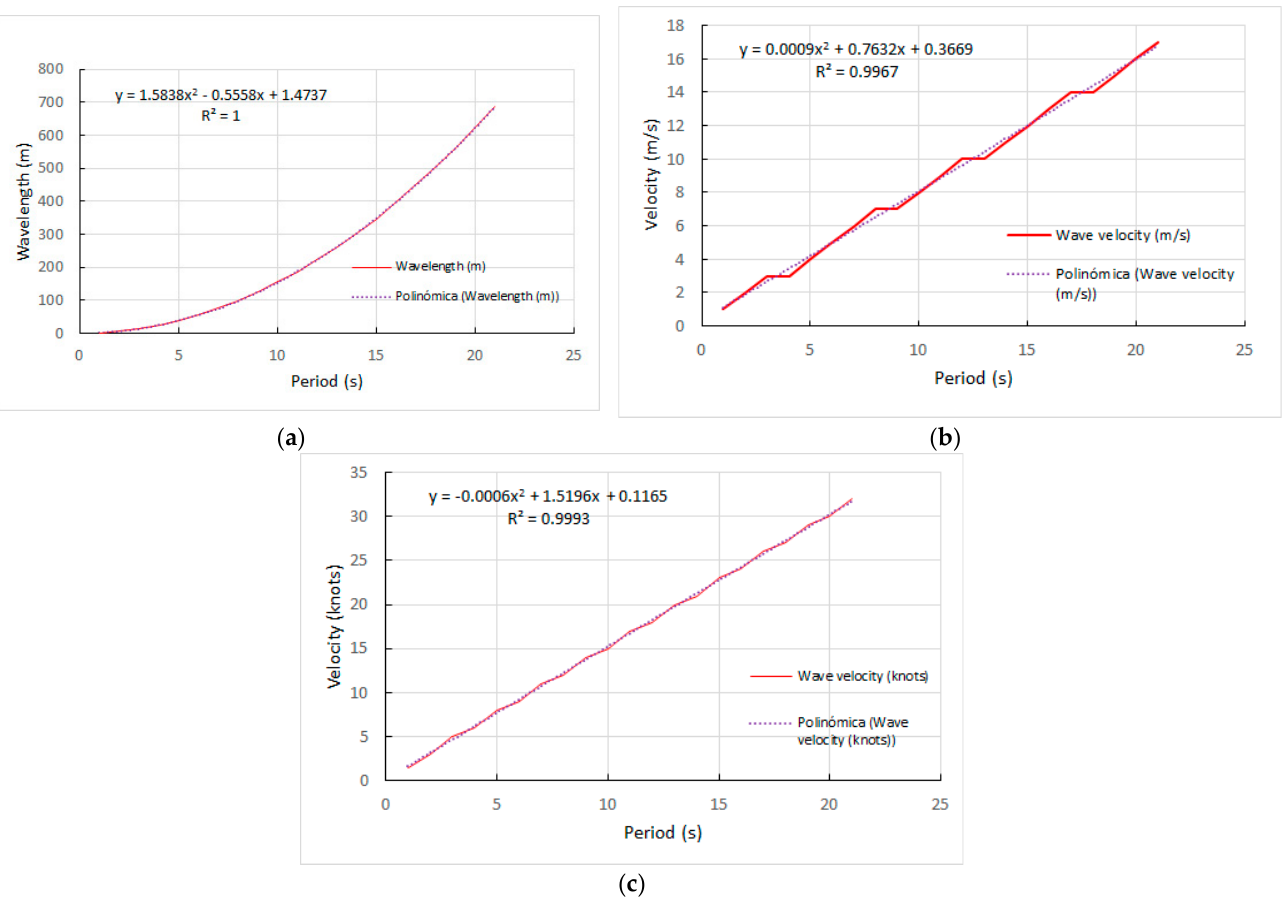
Figure 1. ( a ) Wavelength as a function of period. Precision 100%. ( b ) Velocity in m·s − 1 as a function of period. Precision 99.67%. ( c ) Velocity in knots as a function of period. Precision 99.93%.